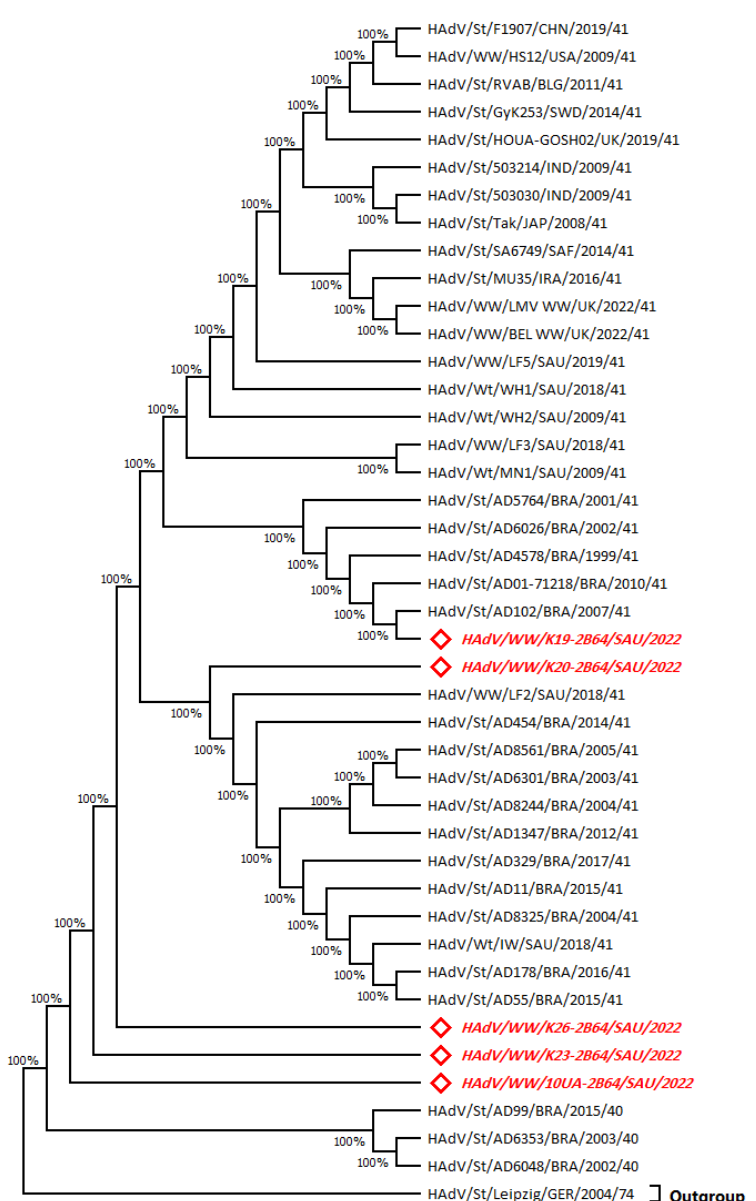
Figure 3. Phylogenetic tree for the HAdV hexon-derived sequences constructed by the maximum likelihood method and Tamura three-parameter model. The evolutionary history was inferred by using the maximum likelihood method and Tamura 3-parameter model. The tree with the highest log likelihood (−742.94) is shown.